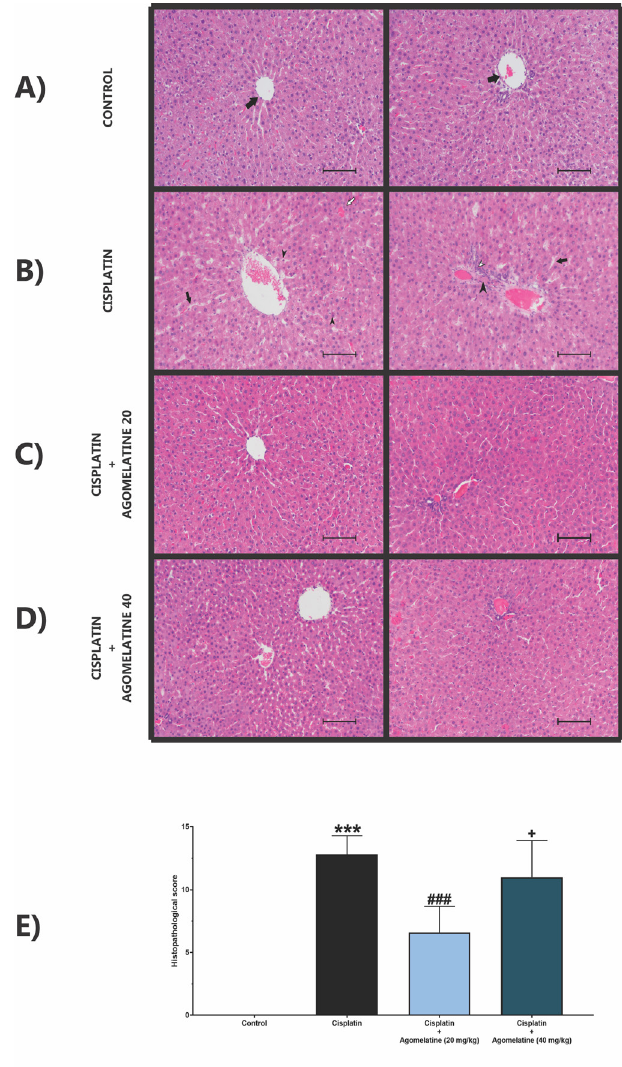
FIGURE 5 - Histopathological presentation of liver tissue with H&E staining. Scale bar=50 µm with 40x magnification. Standard liver histology in the control group. Representation of terminal hepatic venule (black arrow) and hepatic cords circumventing area with the normal sinusoidal look (a). Dilatation in sinusoids (black arrow), vascular congestion (white arrow) and hepatocellular degeneration (white arrowhead) in the cisplatin group (b). Compared with cisplatin group, there were significantly fewer pathological findings in the agomelatine 20 mg/kg group (c). But at the dose of 40 mg/kg agomelatine, similar findings with the cisplatin group were present (d). Total histopathological scores of all groups (e). All data represented as mean±SD and stand for three animals per group. *** p<0.001 versus control group and ### p<0.001 and + p<0.05 versus cisplatin+agomelatine (20 mg/kg)